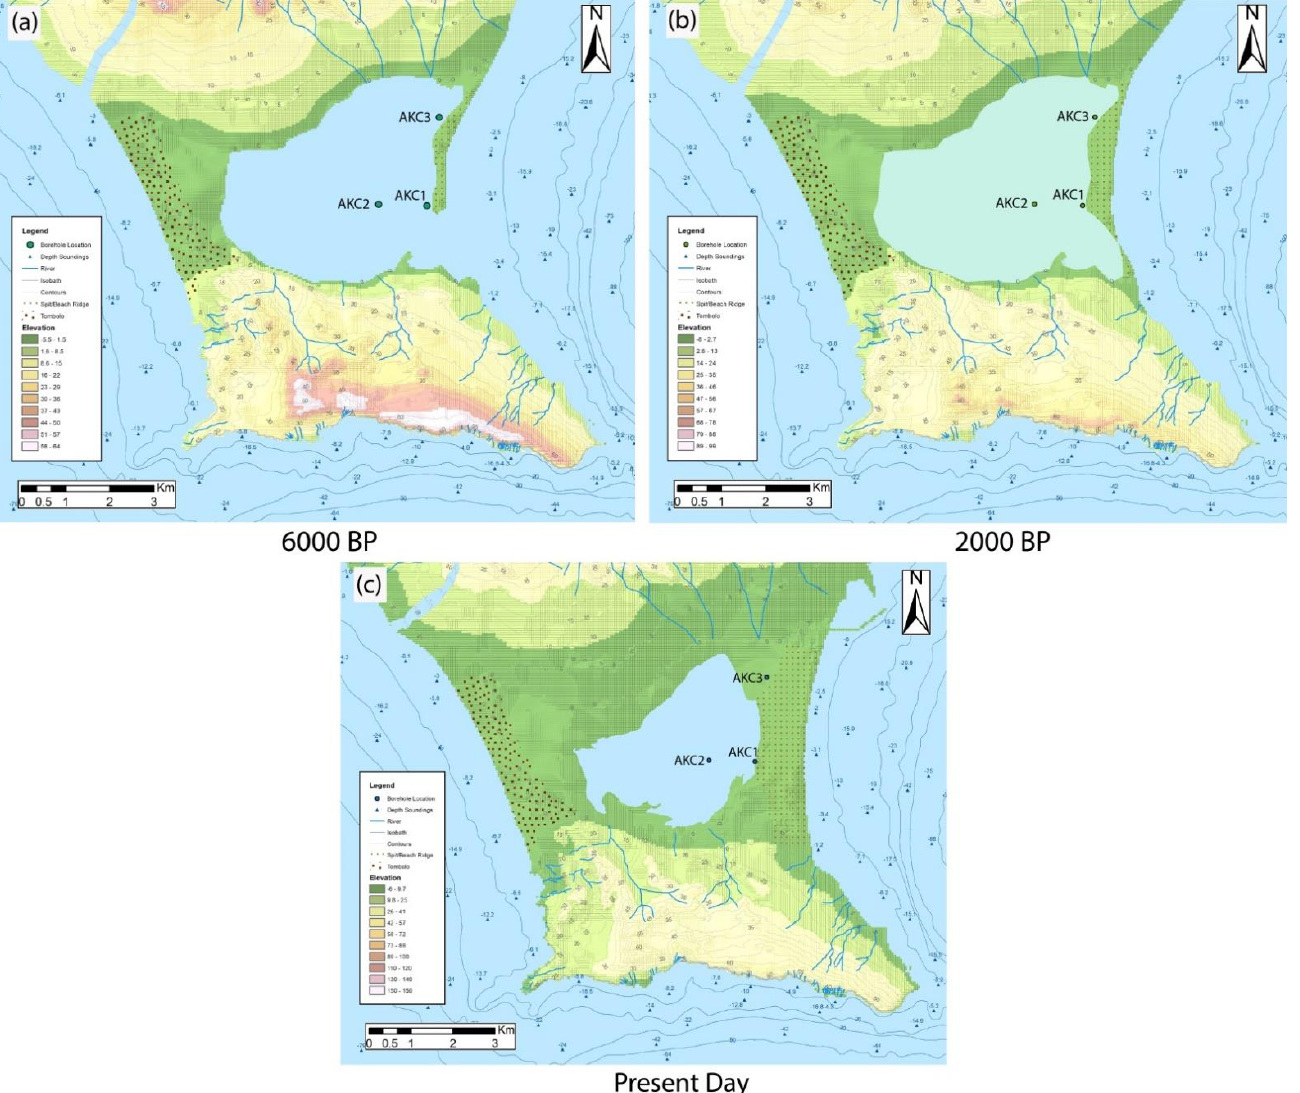
Figure 6. Palaeogeographic reconstruction of the Akrotiri peninsula. ( a ) Palaeogeographic reconstruction of study area ~6000 BP. ( b ) Palaeogeography and paleocoastline ~2000 BP. ( c ) Present state of the study area.